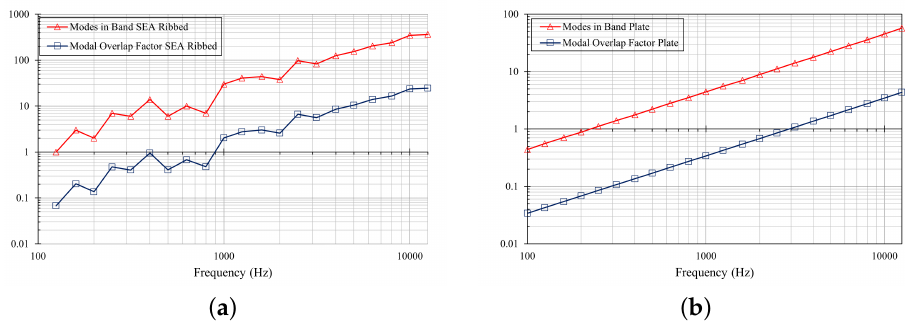
Figure 10. Modal overlap factor and modes in band: ( a ) SEA Ribbed and ( b ) Hybrid models. The vibro-acoustic responses, obtained from the different models, are plotted within the respective frequency validity range. Such results are regrouped according to the type of elements used to model the stringers: 1D FE (Figure 11) or 2D FE (Figure 12).